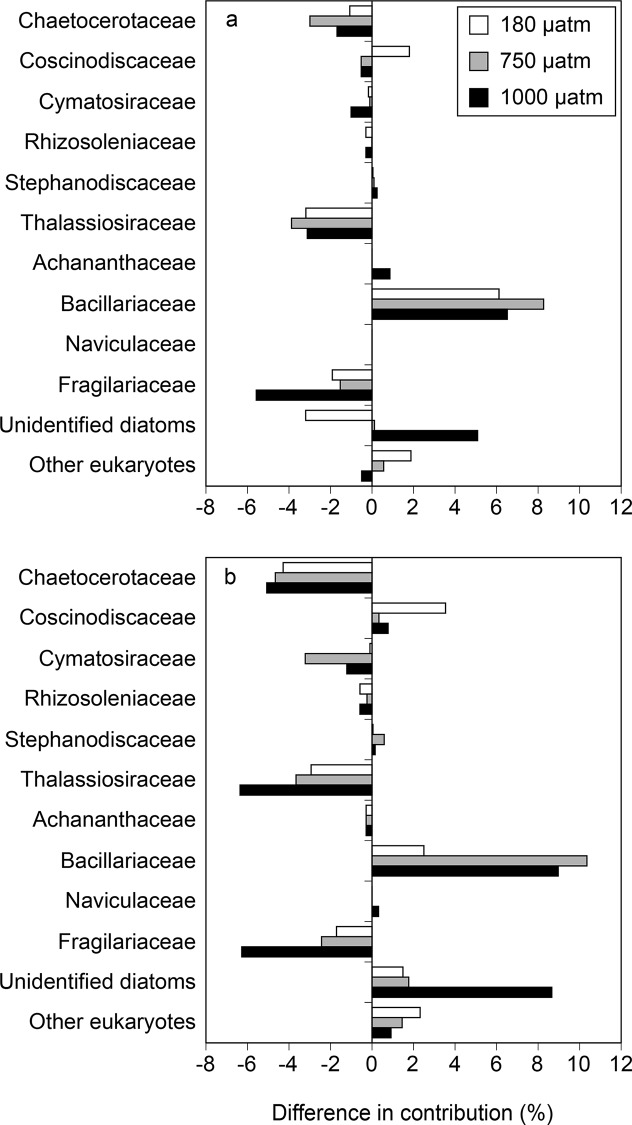
Percent differences in rbcL contribution (%) between the control (350 μatm CO2) and the other pCO2 treatments in the (a) DNA and (b) cDNA libraries.